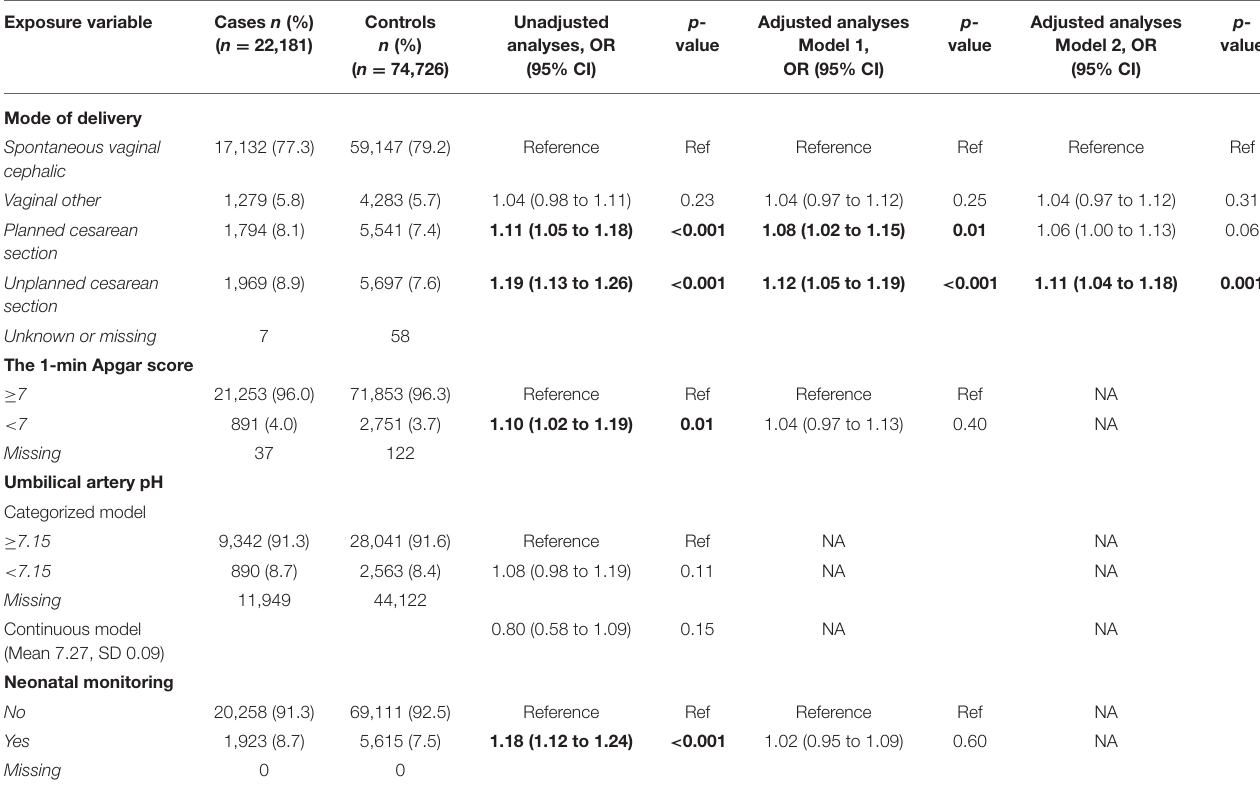
TABLE 1 | Associations between exposures and anxiety disorders in the unadjusted and adjusted analyses. Exposure